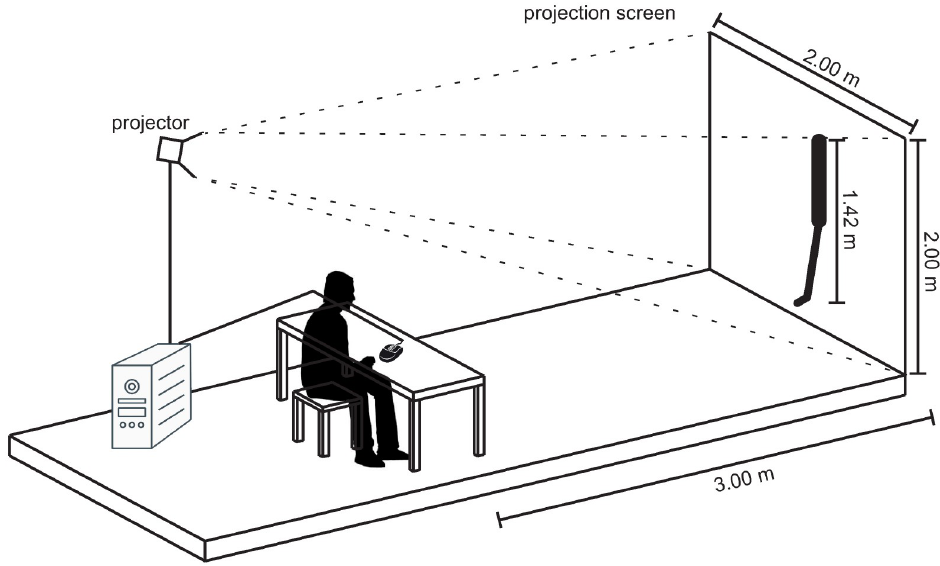
Fig 8. Experimental setup. Schematic representation of the experimental setup with the projection screen and the position of the participant.